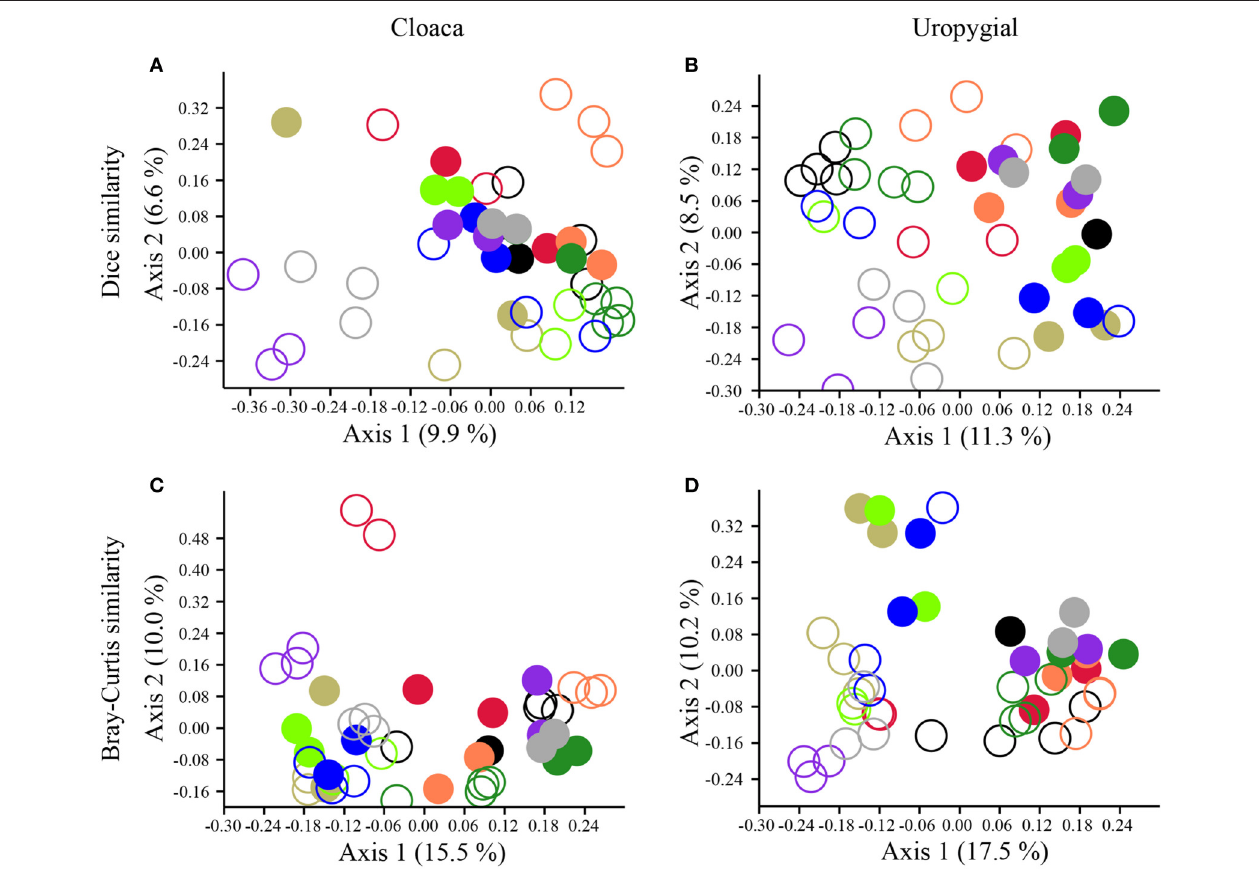
FIGURE 4 | PCoA plots illustrating separation in the (A,B) composition (Dice similarity) and (C,D) structure (Bray-Curtis similarity) of cloacal and uropygial gland microbiota of juncos based on age class and nest identity. Closed circles denote adults, while open circles denote nestlings. Color-coding reflects nest